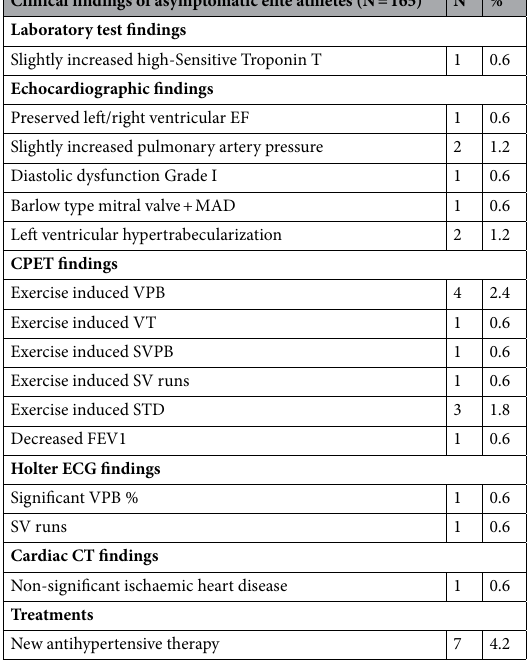
Table 2. Clinical findings of basic, cardiopulmonary exercise testing and further examinations and treatments among 165 asymptomatic elite athletes 93.5 days (IQR: 66.8–130.0 days) after SARS-CoV-2 infection. EF Ejection fraction; MAD Mitral annular disjunction; CPET Cardiopulmonary exercise testing; VPB Ventricular premature beats; VT Ventricular tachycardia; SVPB Supraventricular premature beats; SV Supraventricular; STD ST-segment depression; FEV1 Forced expiratory volume during the first second; CT Computer